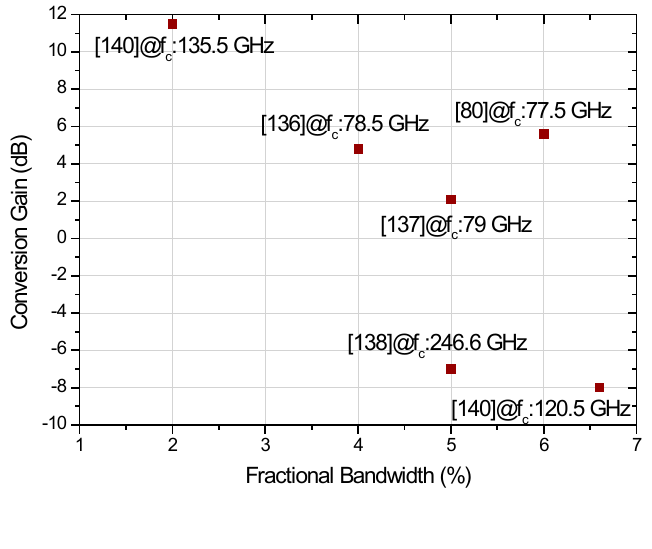
Figure 11. CG versus fractional bandwidth of the recent published MMW SiGe mixers. Data taken from [80,136–140].